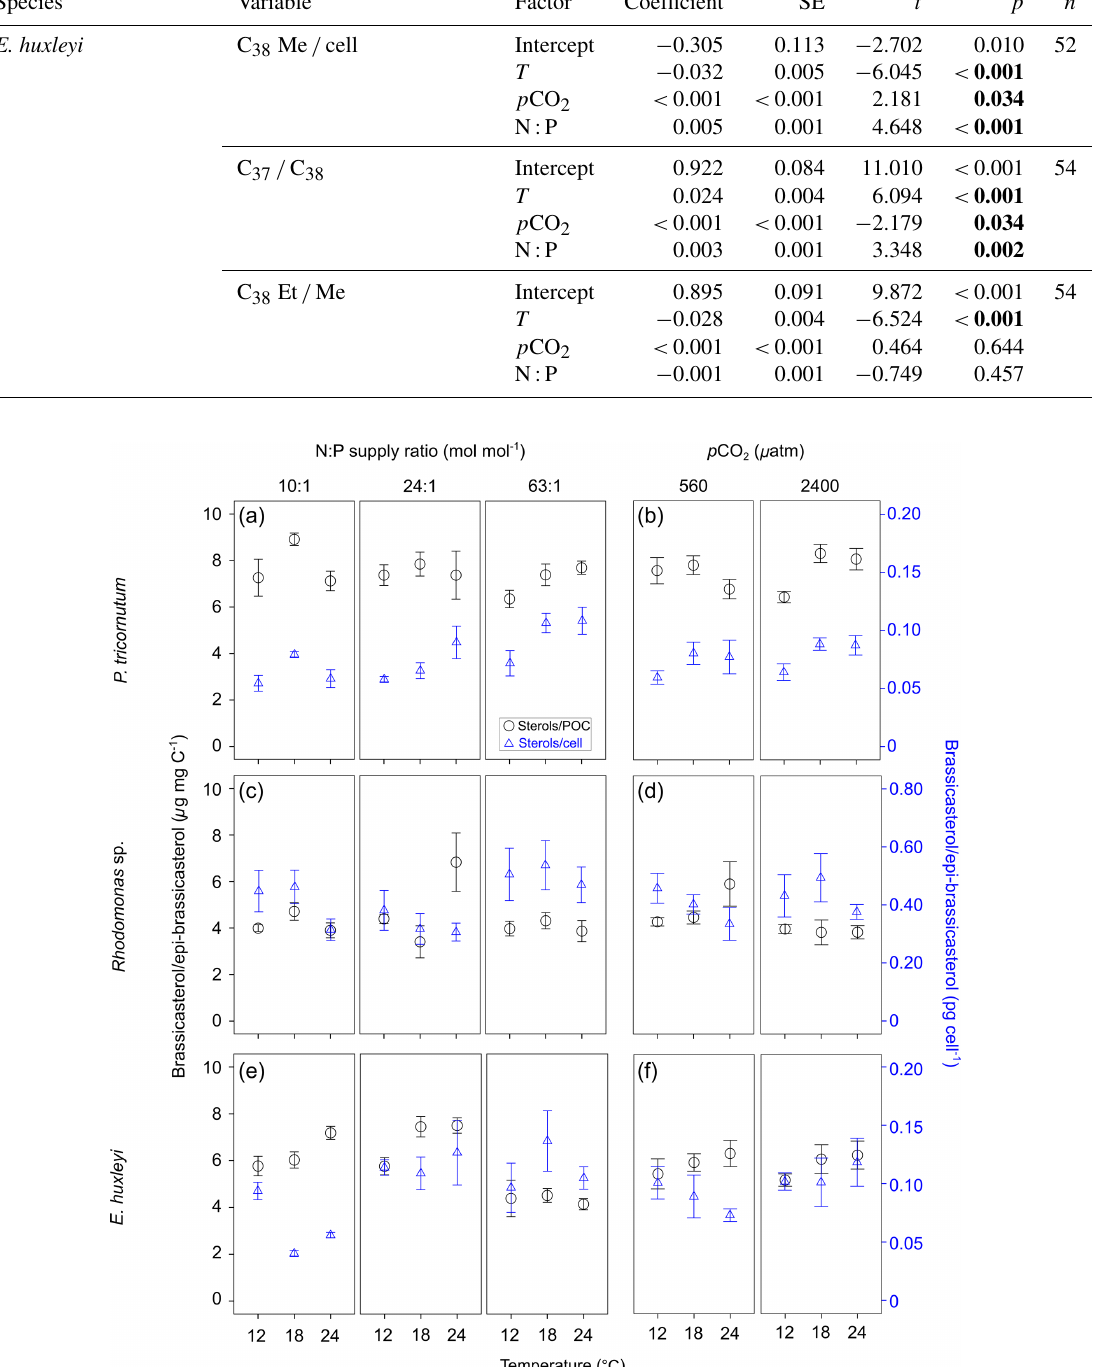
Figure 1. Carbon-normalized (open circles) and per-cell (open triangles) contents of brassicasterol / epi-brassicasterol (mean ± SE; µgmgC − 1 and pgcell − 1 , respectively) in response to the changes in temperature, N:P supply ratios and p CO 2 in Phaeodactylum tri- cornutum (a, b) , Rhodomonas sp. (c, d) and Emiliania huxleyi (e, f) . Triplicates were set for each treatment.